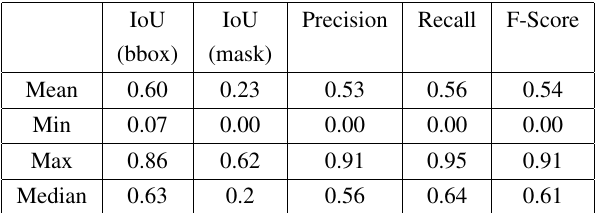
Table 3. Instance segmentation results.